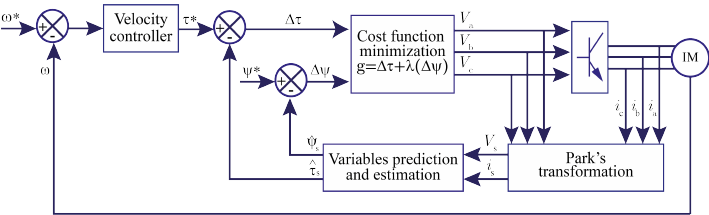
Figure 5. Block diagram of